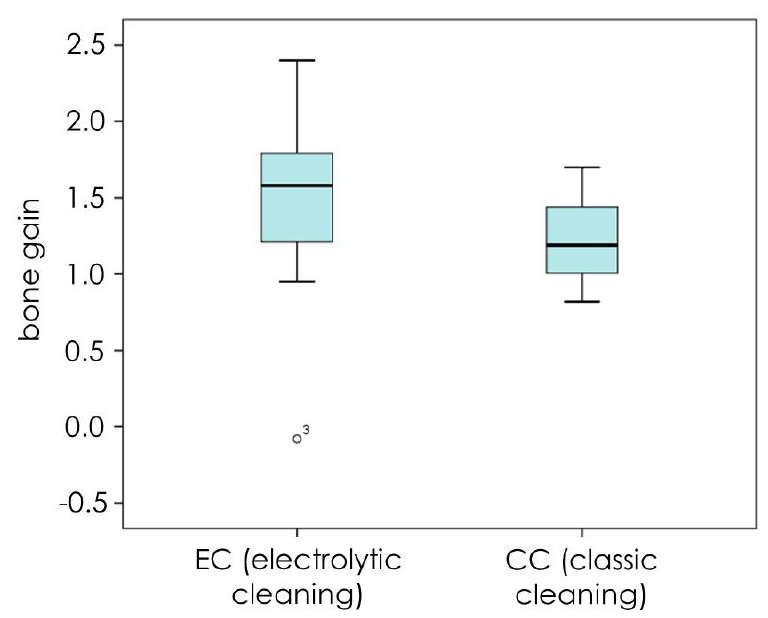
Figure 9. Bone gain for submerged implants at T5 in CC (8 implants) and EC (9 implants) groups display higher bone gain for the EC group.